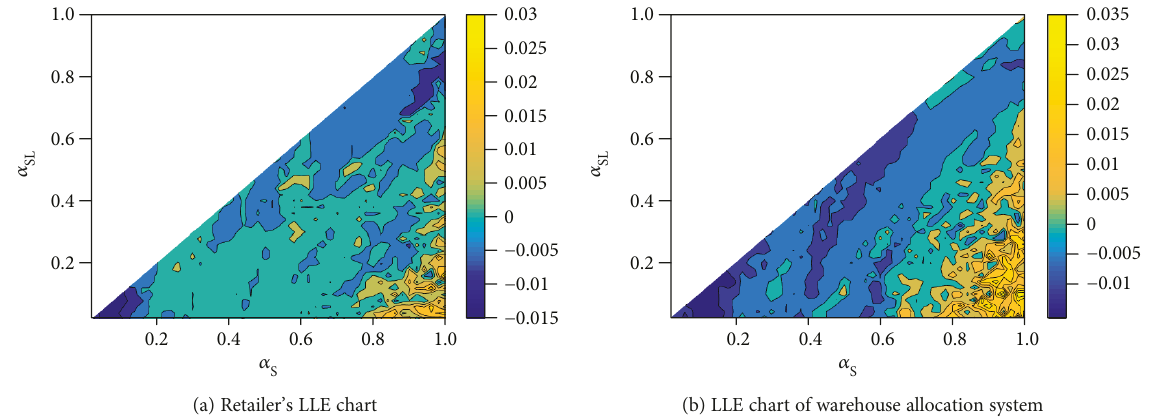
Figure 5: LLE diagram of members under the scenario of random demand obeying normal distribution.